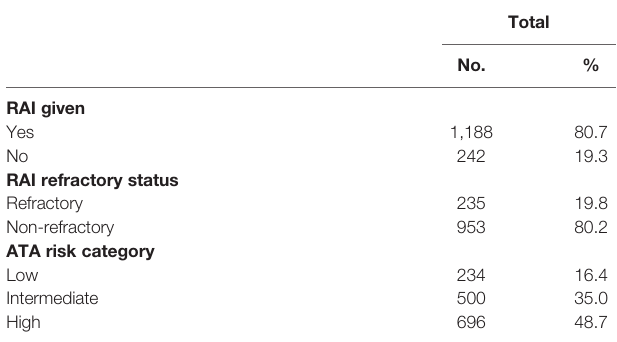
TABLE 1 | Patient characteristics for adult PTC ( n =